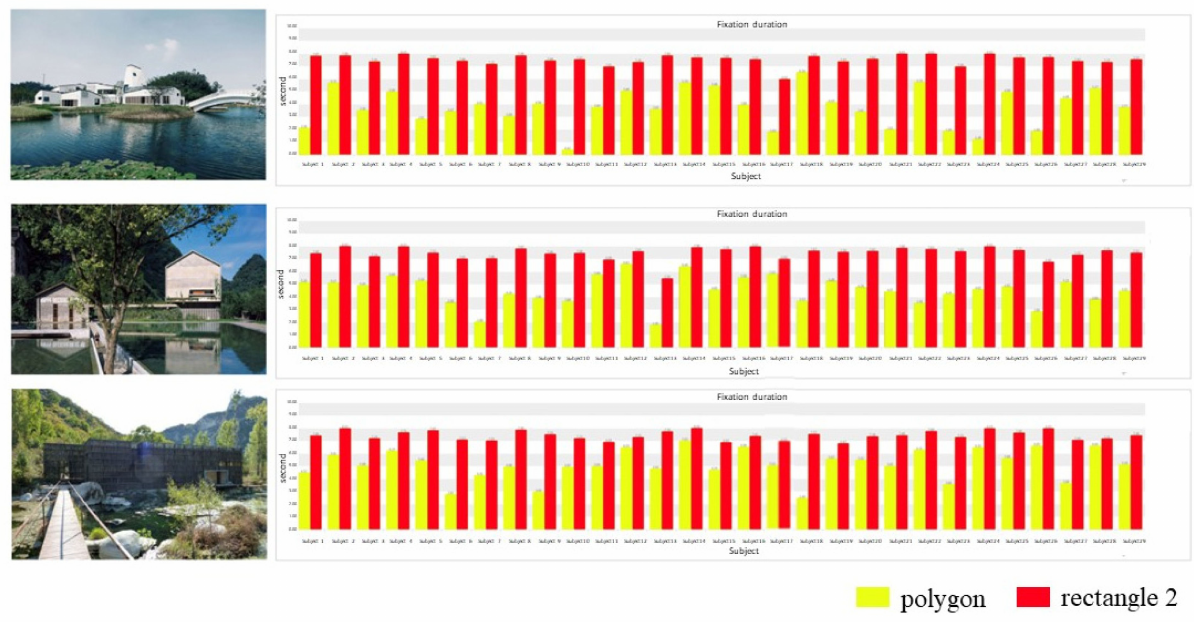
Figure 3. Fixation durations of the first